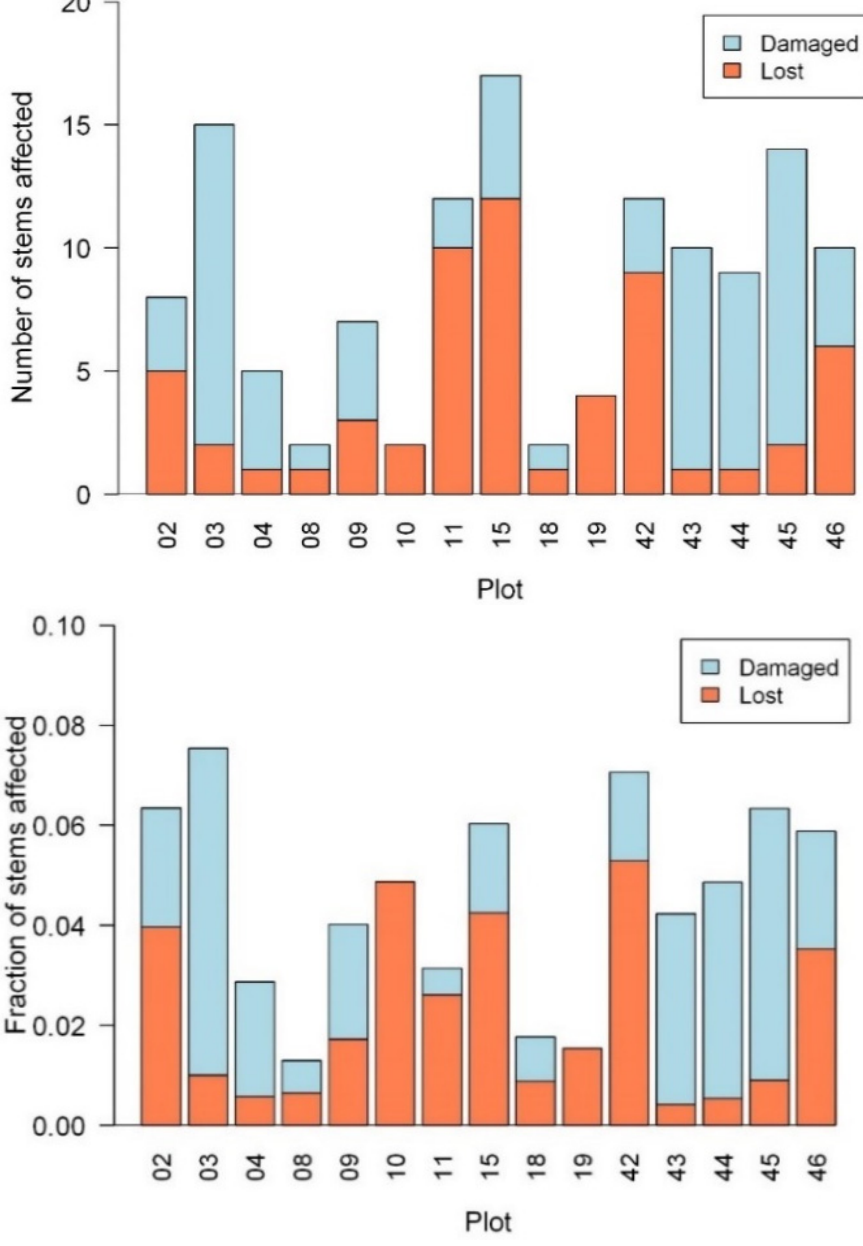
Figure 4. The number ( upper ) and the fraction ( lower ) of affected plant stems in the 15 plots, including the categories of Lost and Damaged.